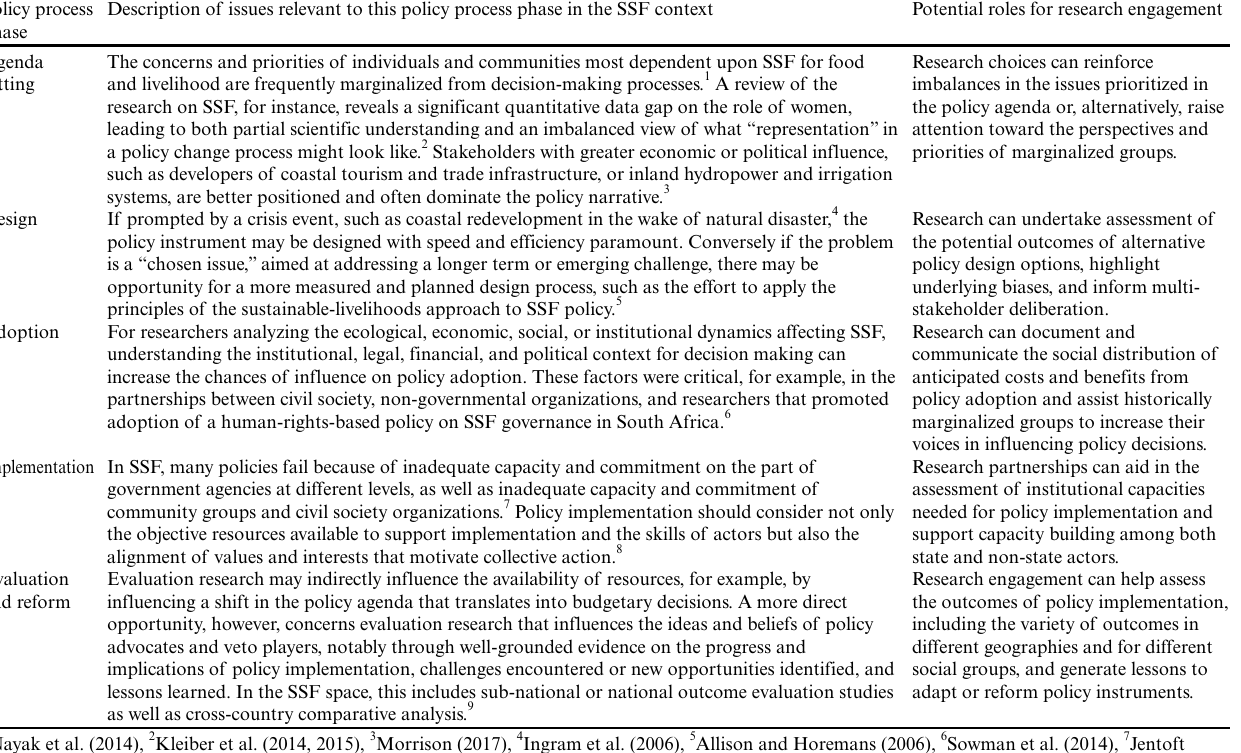
Table 1. Five phases of the policy process (Resnick et al. 2015, 2018) where there is a potential role for research engagement in the context of small-scale fisheries (SSF)